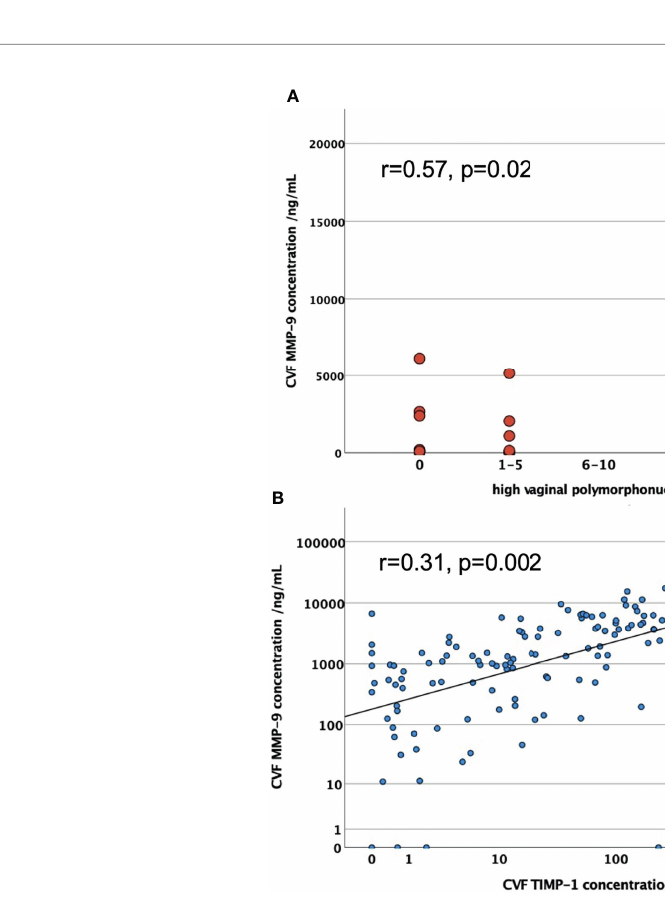
FIGURE 1 | (A) Scatter graphs to explore correlation of CVF MMP-9 concentrations with high vaginal polymorphonuclear leucocyte counts in PWLWH; (B) Scatter graph to explore correlation between CVF MMP-9 and TIMP-1 concentrations in PWLWH. r = correlation co-ef fi cient, controlled for maternal age, BMI and